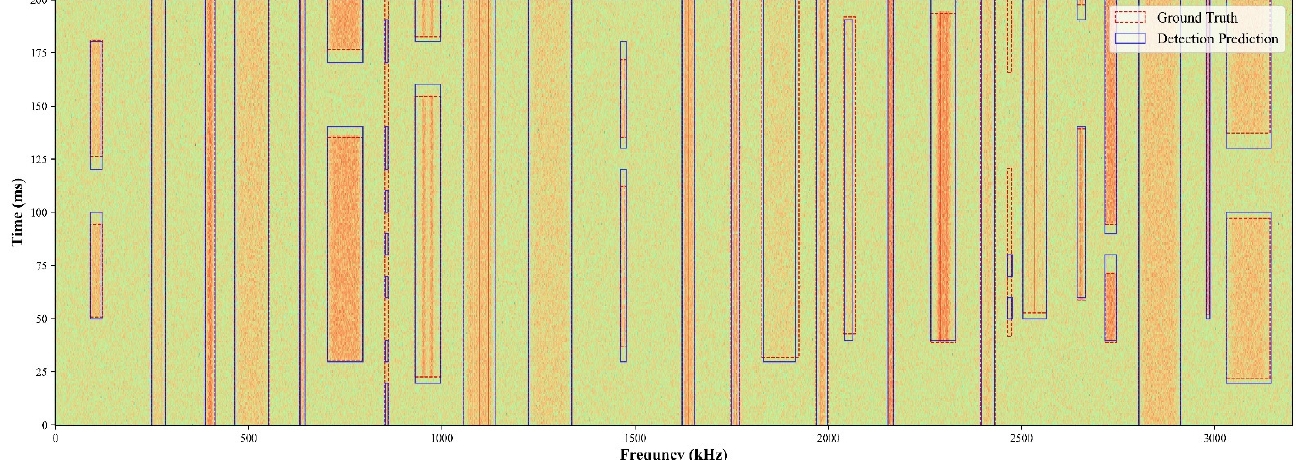
Figure 8. The second example of the FFSCN-FMN detection results. Here, the signal time duration is 200 ms, and we split it into 200 consecutive frames of the broadband power spectra and grouped them into 20 FFSCN-FMN inputs without frame overlap.